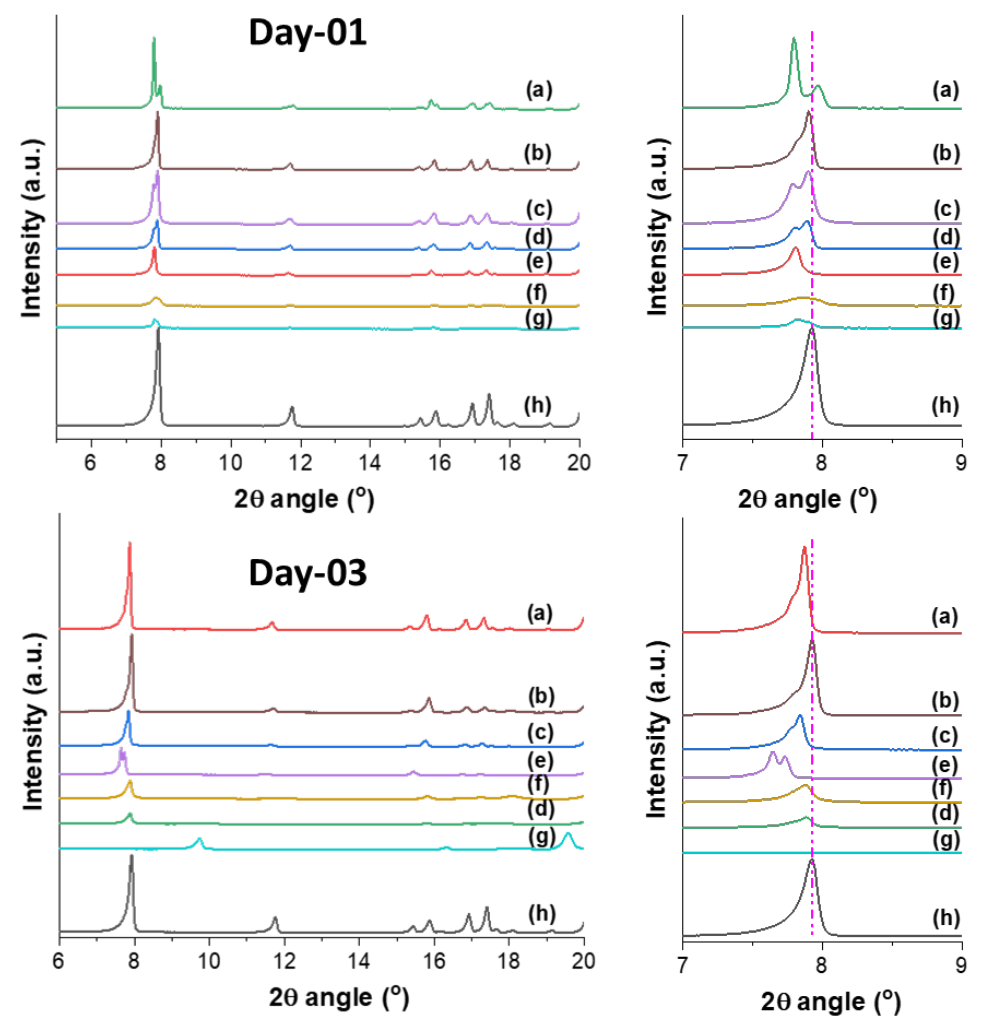
Figure 4. XRPD patterns taken from the QUF-001 mixed with different solvents after Day 1 (upper frames) and Day 3 (bottom frames). The solvents are: ( a ) acetonitrile, ( b ) THF, ( c ) benzene, ( d ) DCM, ( e ) hexadecane, ( f ) methanol, ( g ) isopropanol; patterns ( h ) belong to pure (no solvent) activated QUF-001. Frames on the right-hand side show enlarged view of the (001) low 2 θ angle peak(s).